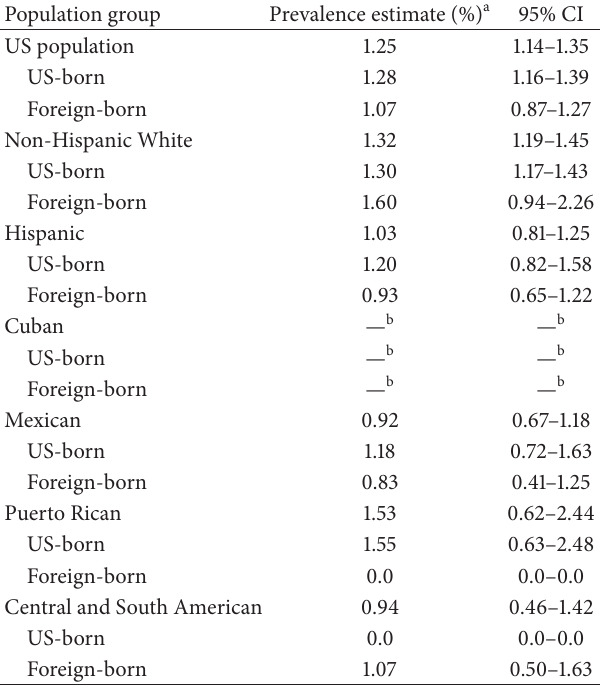
Table 2: Breast cancer prevalence estimates by race and ethnicity, United States: 2009–2013.